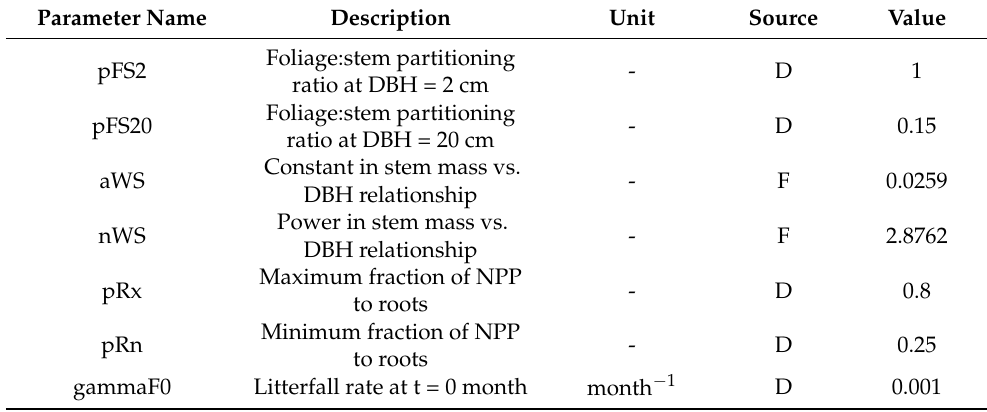
Table A1. Description of parameters, unit, source, and their